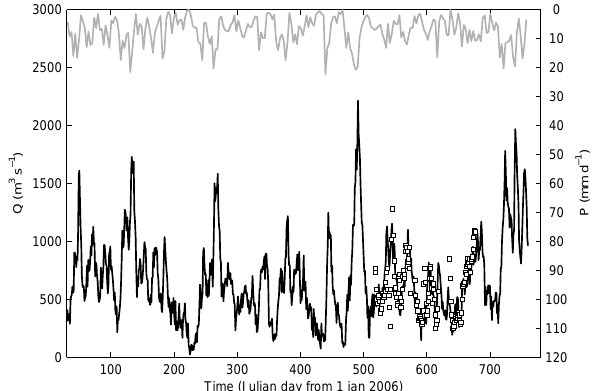
Fig. 9. Simulated river discharge (black line) and observed tidally averaged discharge (squares), along with the three-day average of the daily precipitation (upper grey